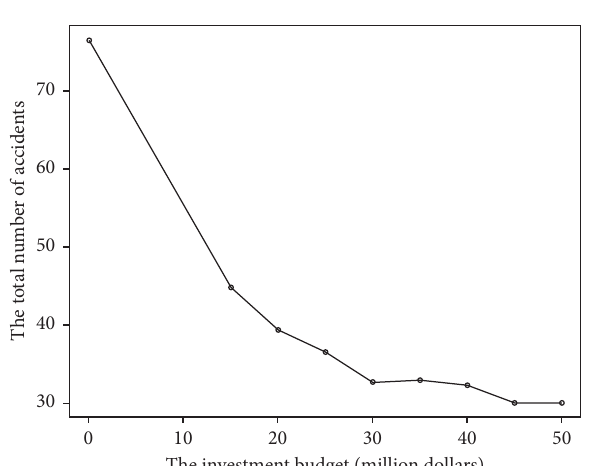
Figure 7: The sensitivity of objective value with respect to varying